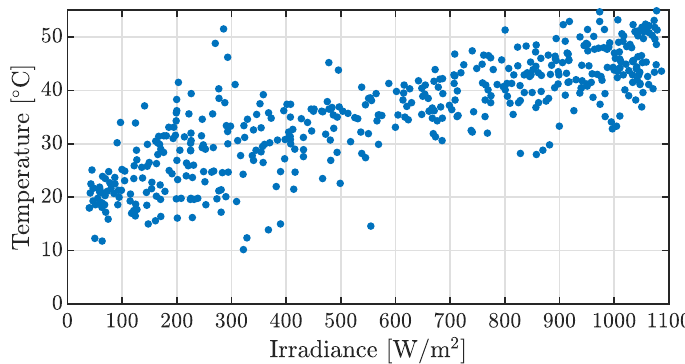
Figure 10. The experimental data used for the training of the NMPPT.